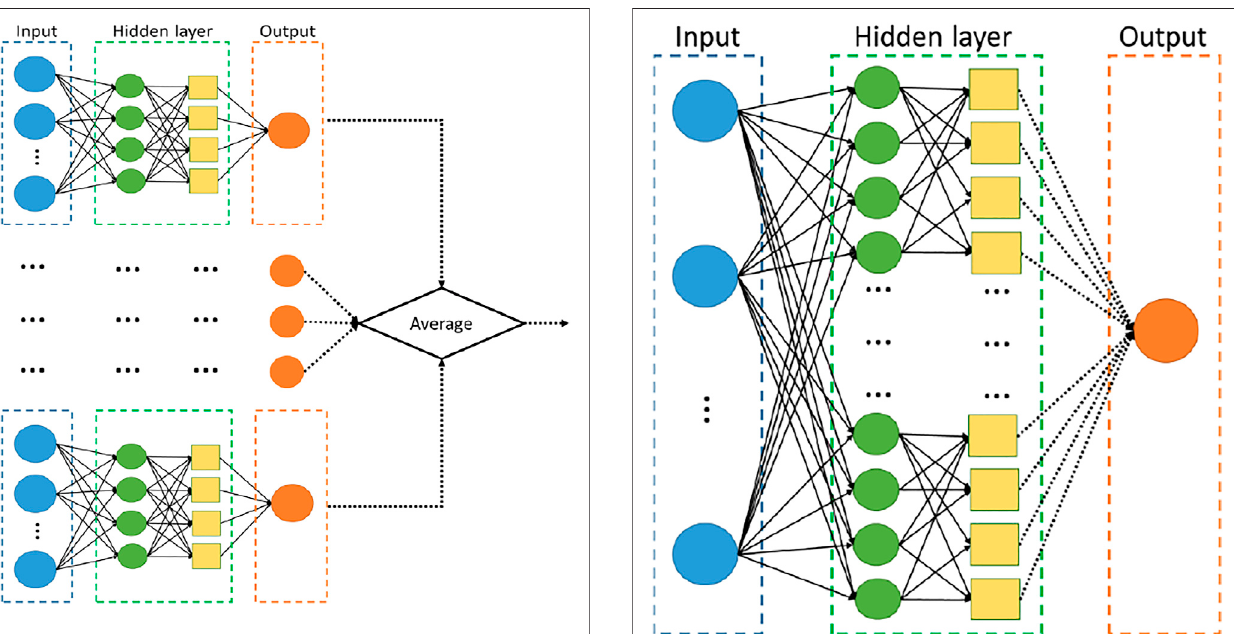
FIGURE 1 | NRF model structure with independent training.